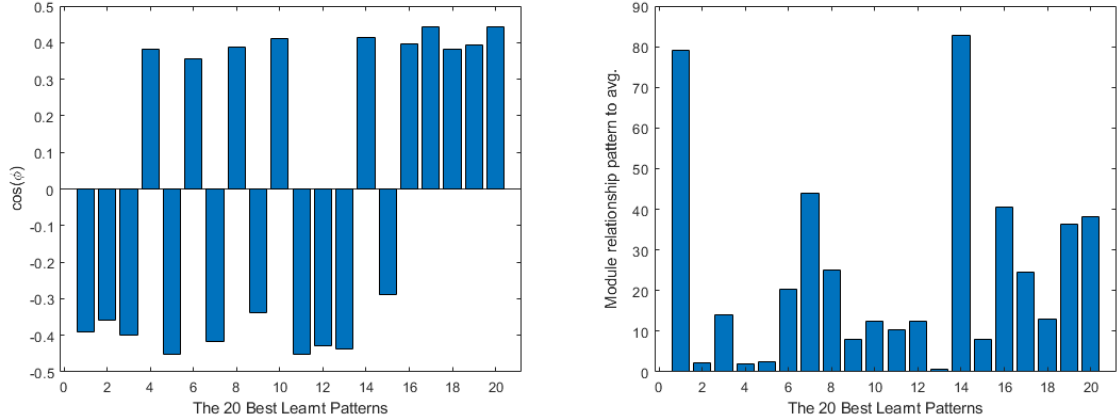
(cid:12) (cid:12) 𝜕𝐿𝑜𝑠𝑠 | relationship to the average ∂ Loss (cid:12) (cid:12) (cid:12) (cid:12) relationship to the average 𝜕𝑊 𝑛 ∂ W n